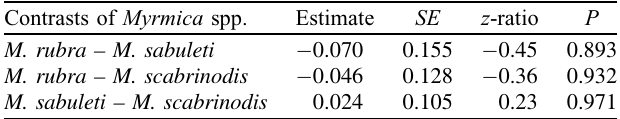
Table 4. Contrasts acquired from the model estimating between- species differences in total thalli number. Contrasts of Myrmica spp.